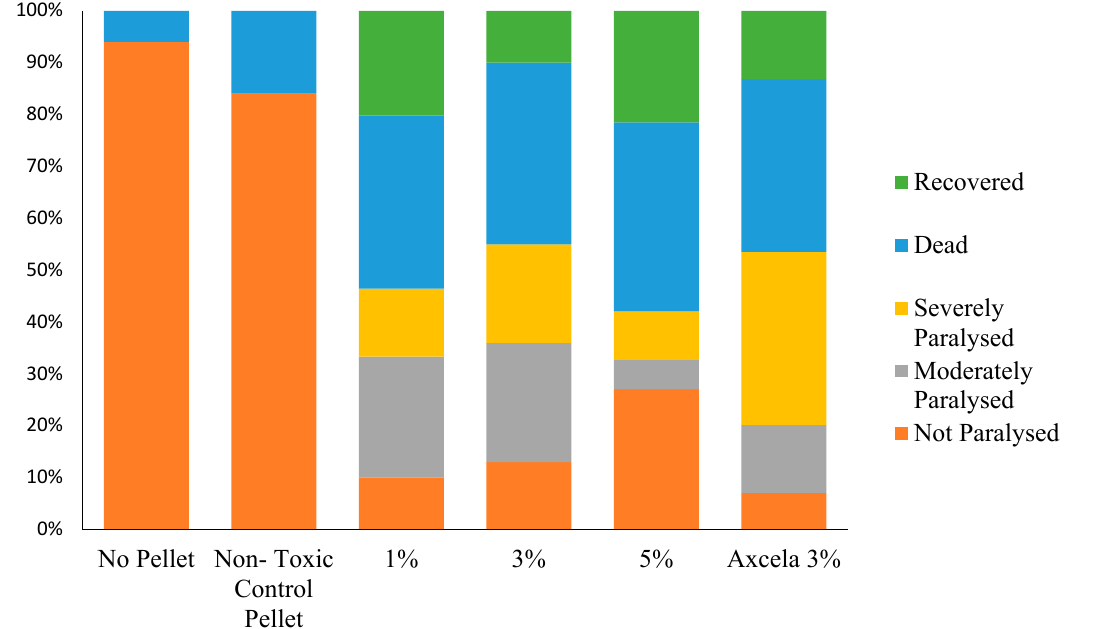
Figure 2. Health status of populations of 30 D. reticulatum after 72 h in a recovery environment after exposure to slug pellets of various metaldehyde content ( n = 30). There was no significant interaction between treatment and the number of slugs paralysed (moderately and severely combined) after initial exposure and 72 h after recovery (X 2 (4) = 1.784, p > 0.05).